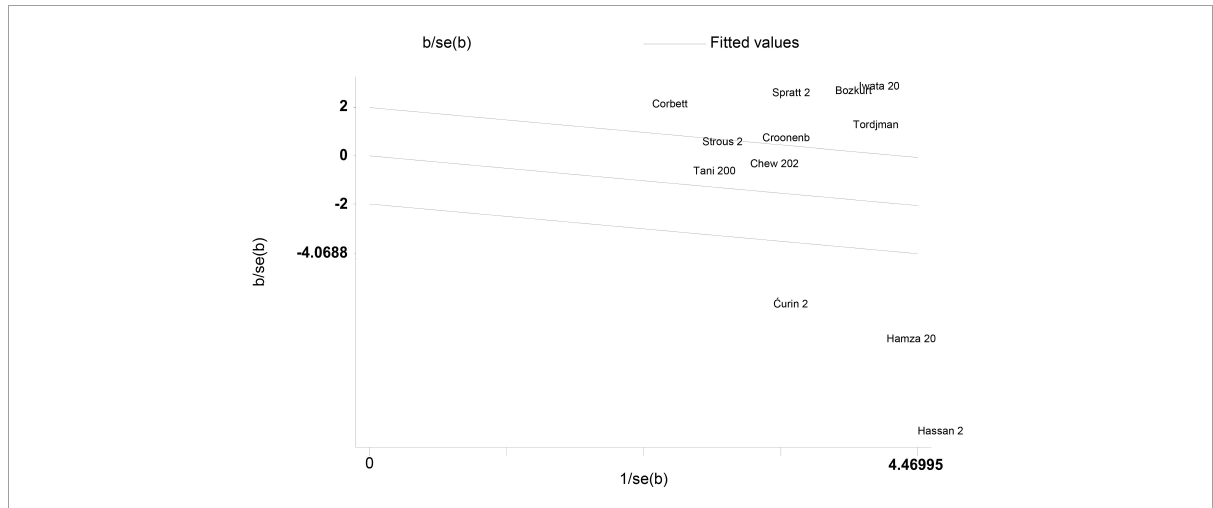
FIGURE5 Galbraith plot for the random-effect meta-analysis.